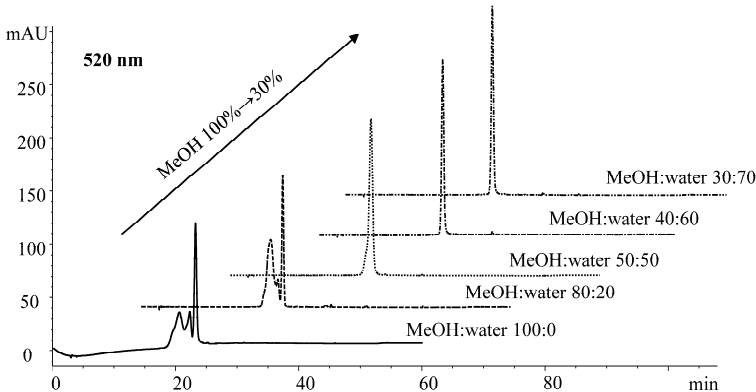
Figure 1. E ff ect of the reconstitution solvent on peak shape as exemplified by cyandin-3- O -glucoside standard (10 µ g / mL) at 520 nm. HPLC conditions as described in Section 2.4.